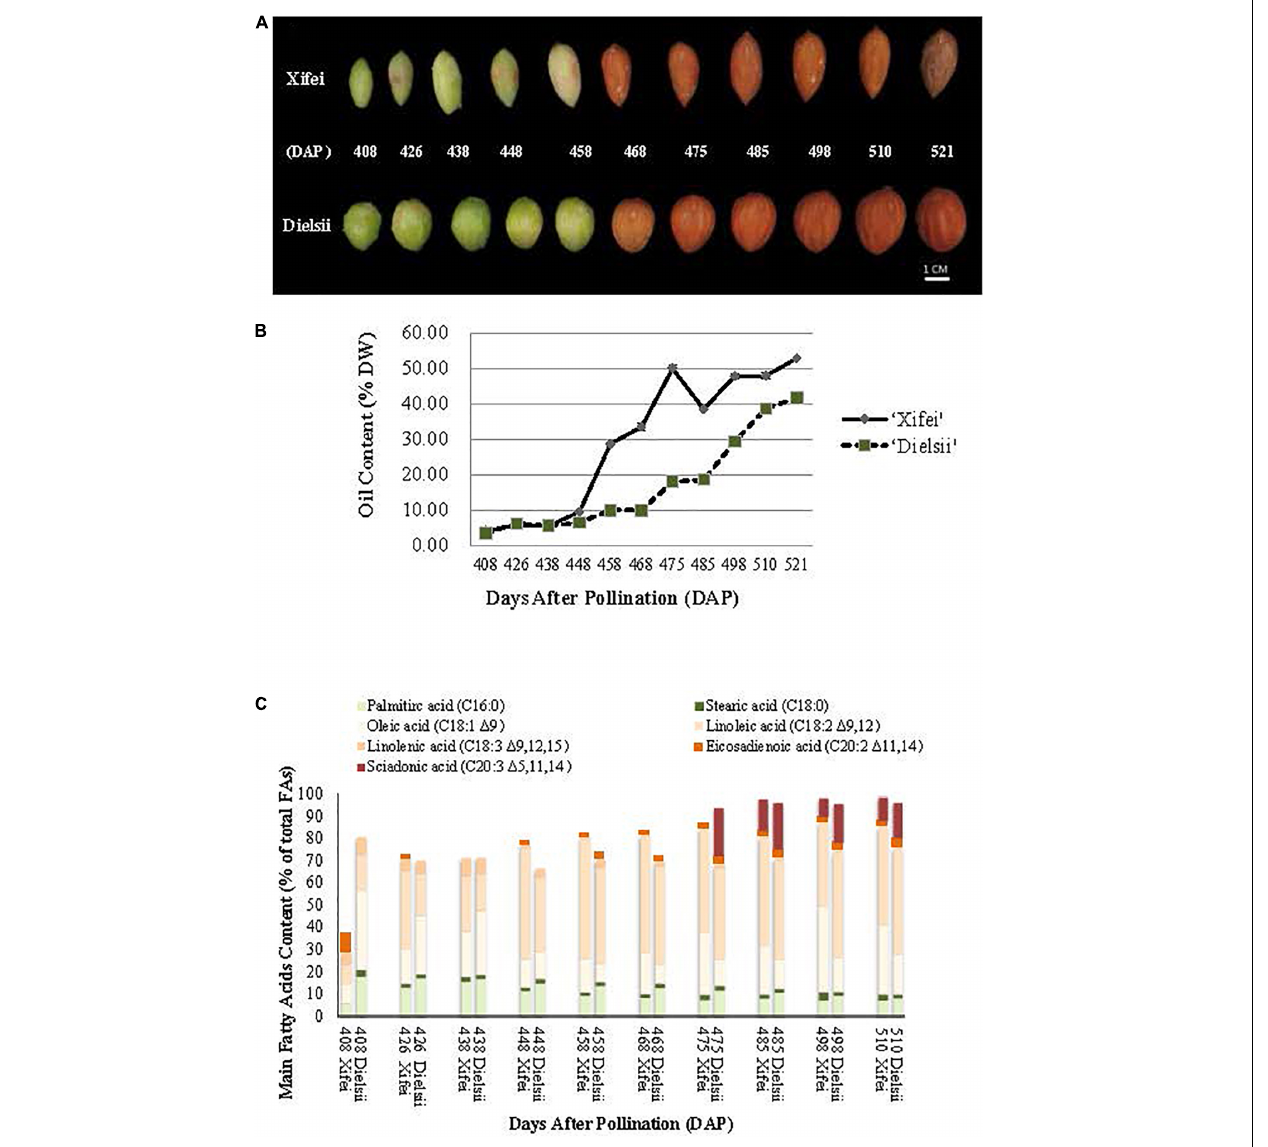
FIGURE 1 | Developing nut-seeds, the content of oil, and FAs in Torreya grandis ‘Xifei’ and T. grandis ‘Dielsii,’ respectively. DAP, day after pollination. (A) Developing nut-seeds of two cultivars at each sampling time. (B) Oil content of ‘Xifei’ (black dots) and ‘Dielsii’ (white dots) at each sampling time, respectively. Values of oil content were expressed as the percentage of dry weight (%DW) of kernels. (C) The content of FA composition in ‘Xifei’ and ‘Dielsii’ at each sampling time was presented as a percentage of total FAs (%), respectively.